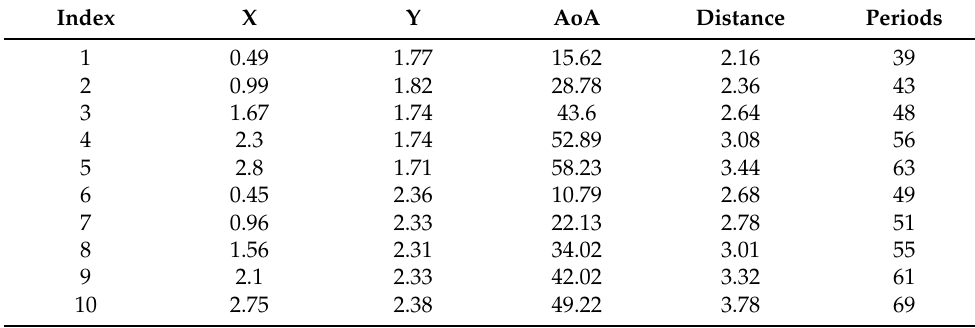
Table A1. Lab Environment Test field coordinates (relative to